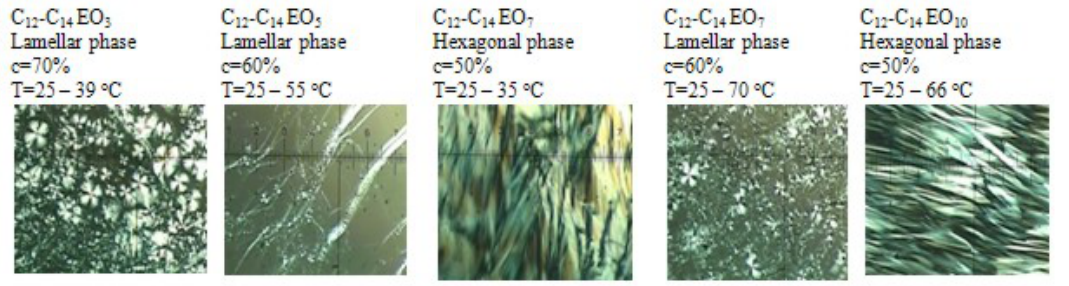
Figure 1. Microscopic examinations of fatty alcohols ethoxylated with 3 (70%), 5 (60%), 7 (50% and 60%), 10 (50%) moles of ethylene oxide under polarized